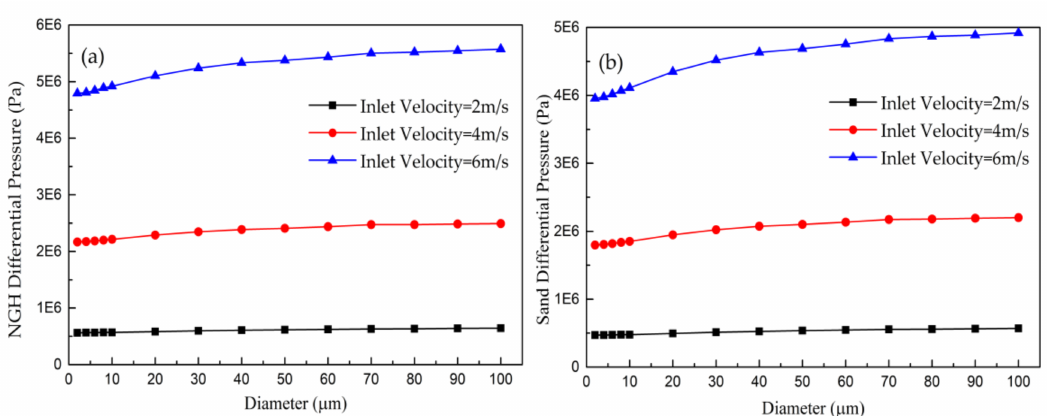
Figure 16. The relationship between particle diameter and di ff erential pressure: ( a ) is for NGH, ( b ) is for sand.